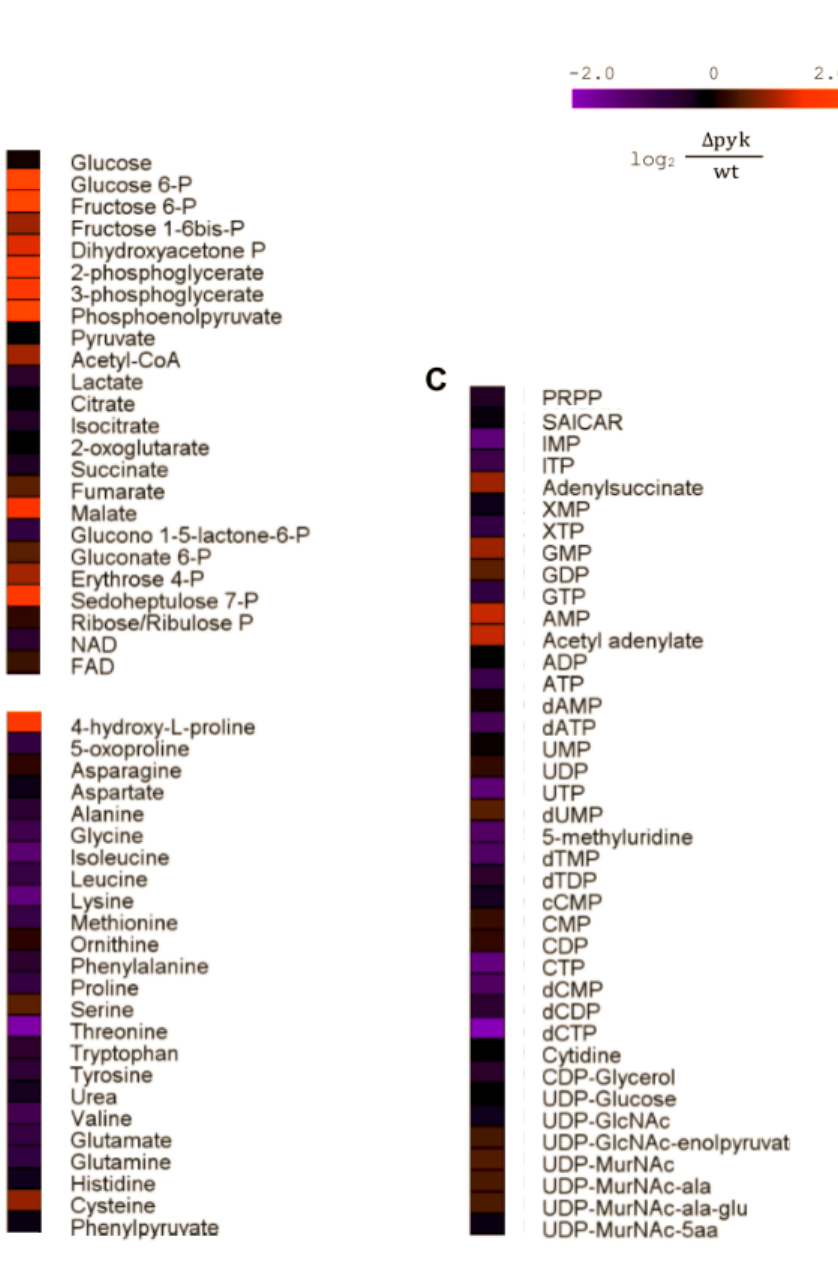
Figure 4. Heat map of intracellular metabolite levels of glycolysis, tricarboxylic (TCA) cycle and Pentose Phosphate Pathway (PPP) ( A ), amino acids ( B ), and intermediates of purine and pyrimidine metabolism and cell wall precursors ( C ), in wt and ∆ pyk under M9GlcPyr cultivation. The color code represents the log 2 FC between ∆ pyk and wt, whereas increased levels are indicated in orange and lower levels in purple. Data are shown as the mean of four biological replicates. P: phosphate.